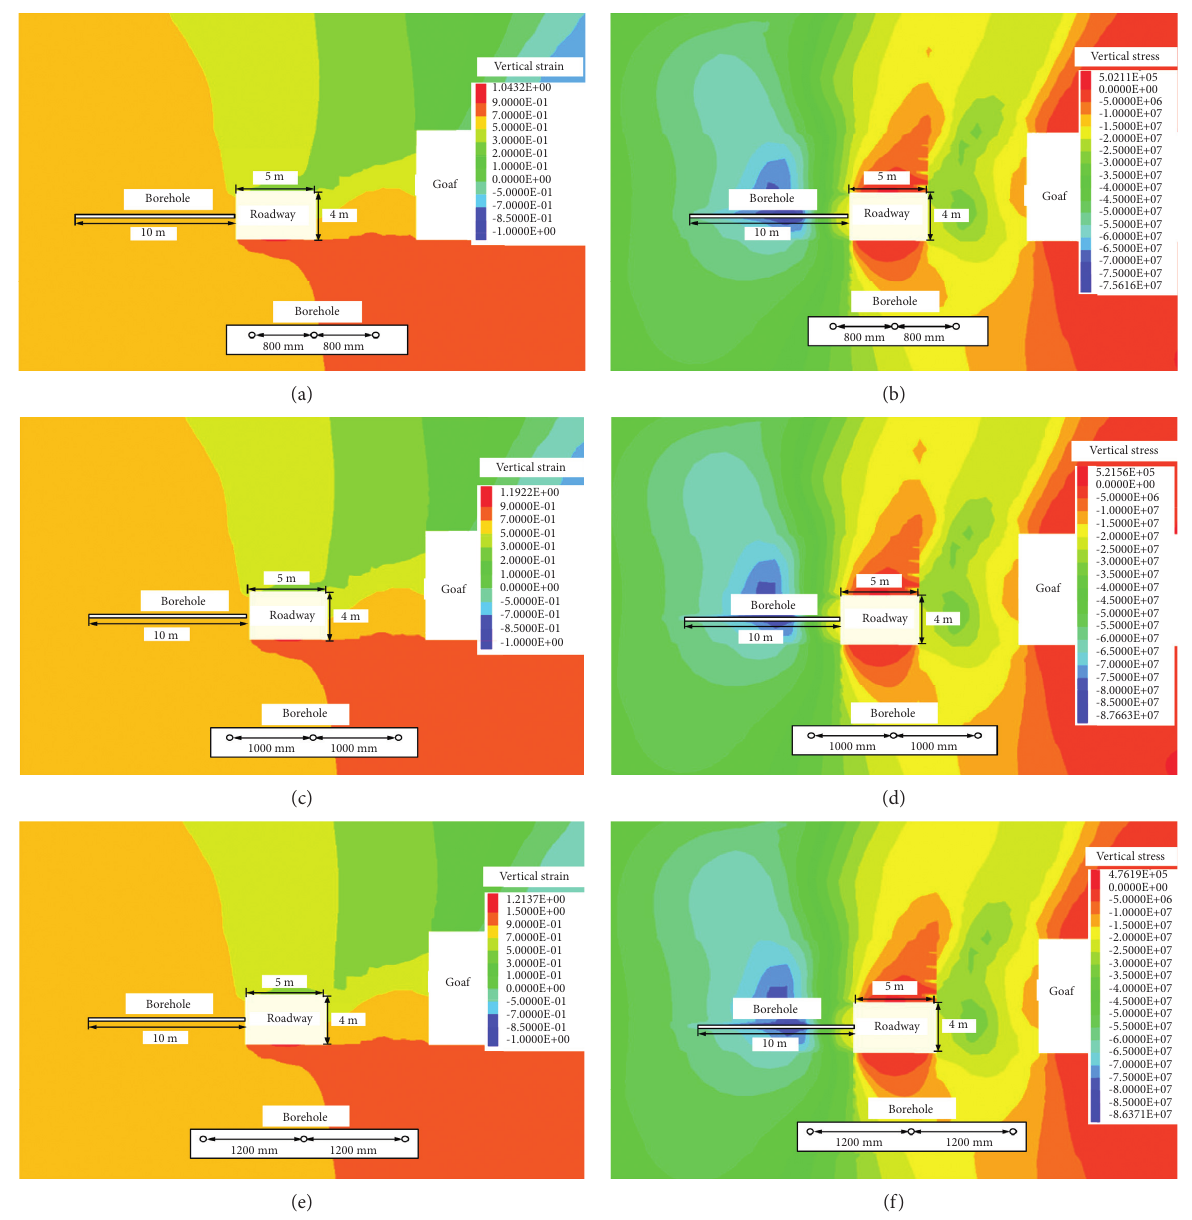
Figure 9: Deformation and stress distribution of surrounding rocks in mining roadway with different spacings of pressure relief boreholes. (a) Vertical strain of 0.8 m; (b) vertical stress of 0.8 m; (c) vertical strain of 1.0 m; (d) vertical stress of 1.0 m; (e) vertical strain of 1.2 m; (f) vertical stress 1.2